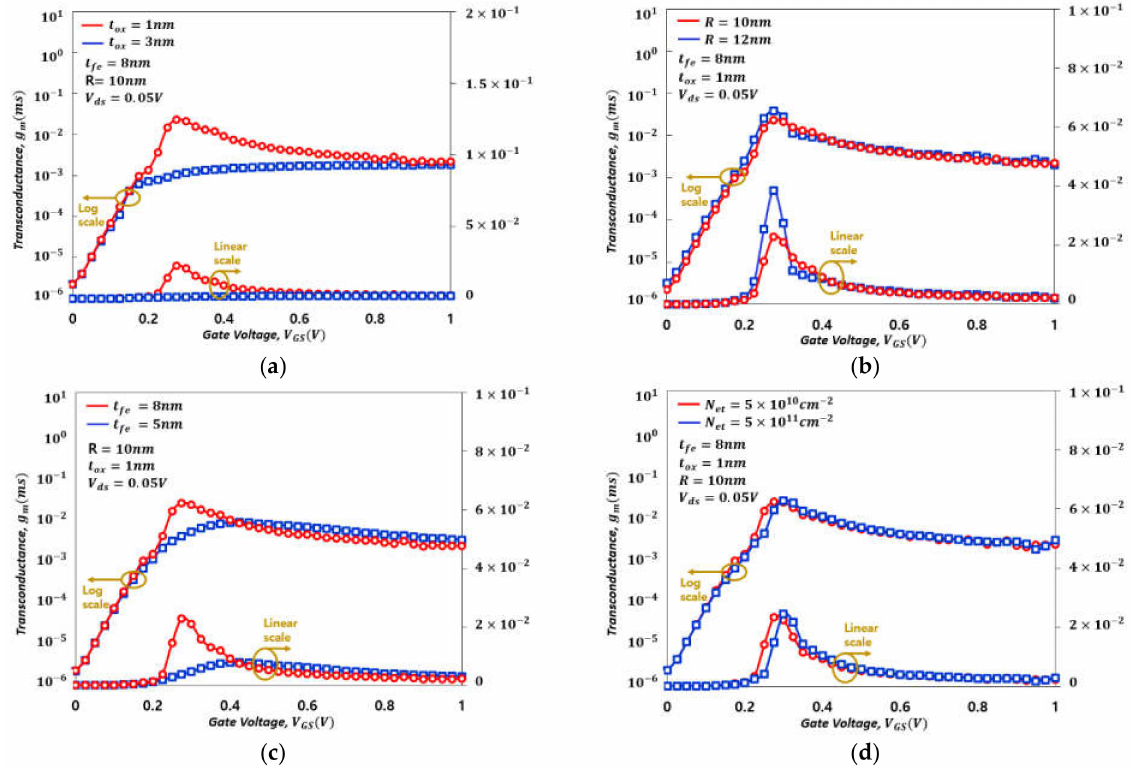
Figure 9. Characteristics of transconductance ( g m ) for various geometries; ( a ) t ox , ( b ) R , ( c ) t fe , and trap density ( d ) N et